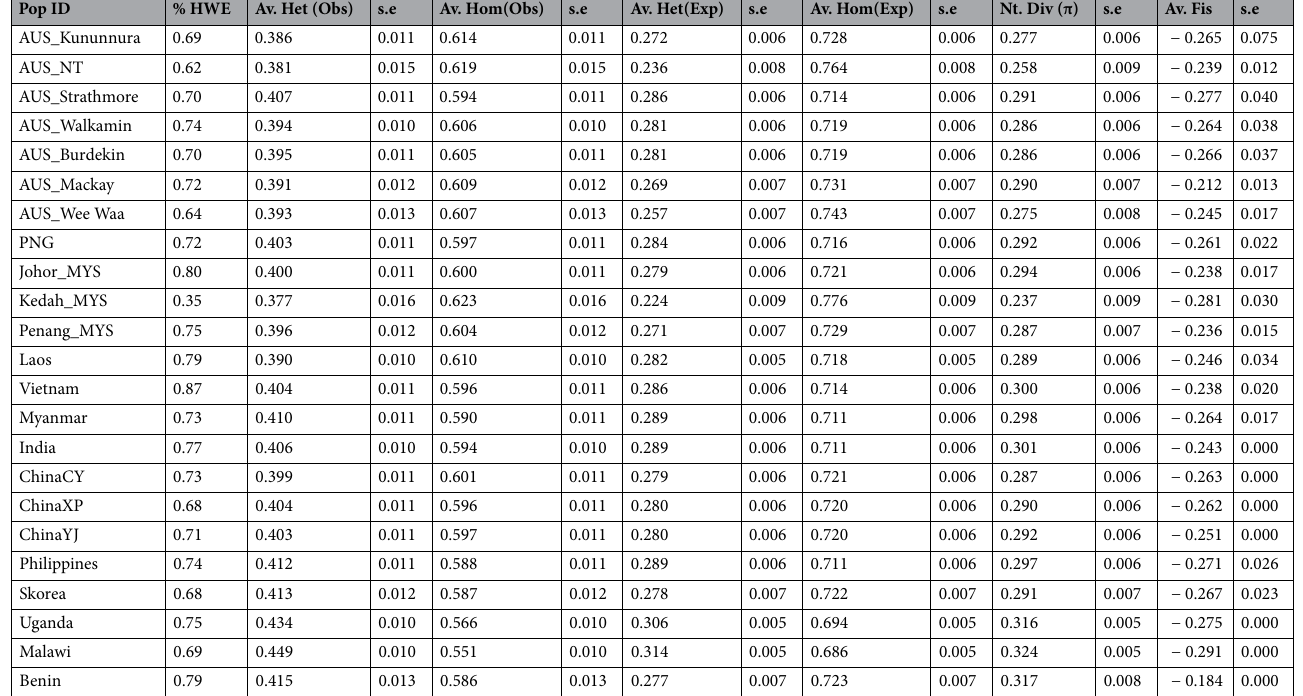
Table 2. Population statistics for Spodoptera frugiperda populations from Southeast Asia (i.e., Malaysia (MYS; Johor, Kedah, Penang), Laos, Vietnam, Myanmar), East Asia (i.e., South Korea), and Pacific/Australia (i.e., Papua New Guinea (PNG), Australia). Populations from Australia (AUS) are Kununurra from Western Australia (WA), Northern Territory (NT), from Queensland (Qld; Strathmore, Walkamin, Burdekin, Mackay), and New South Wales (NSW; Wee Waa). Invasive populations from Benin (BE), Uganda (UG), Tanzania (TZ), Malawi (MW), India (IN), and China (CH, CC, CY, CX) were from 33 . Nucleotide diversity: (Nt Div, π); Avg. Het exp , average expected heterozygosity; Avg. Het obs , average observed heterozygosity; Avg. Hom exp , average expected homozygosity; Avg.